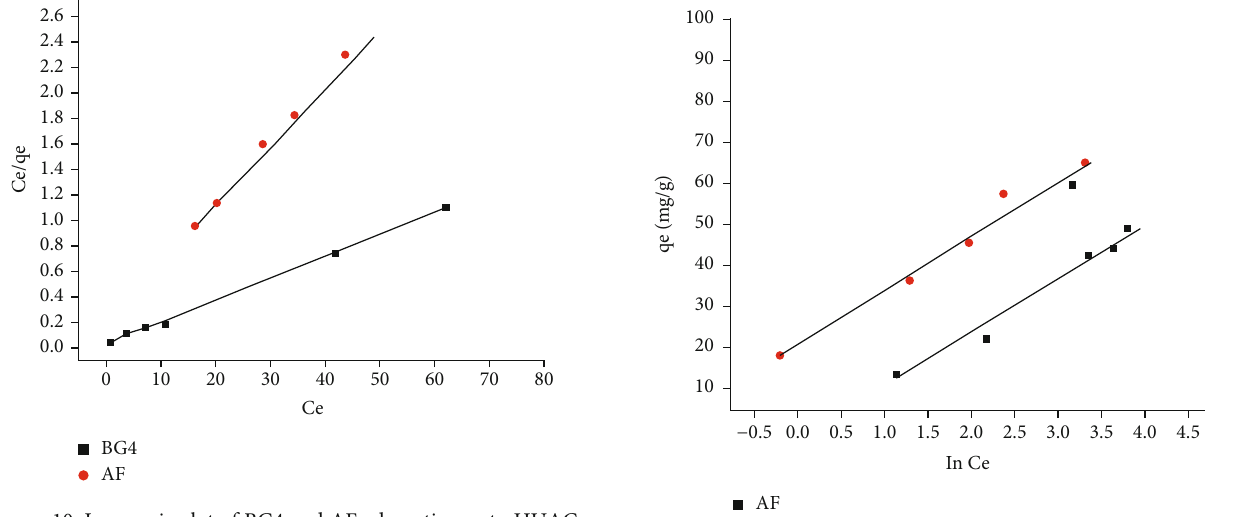
Figure 10: Langmuir plot of BG4 and AF adsorption onto HUAC.